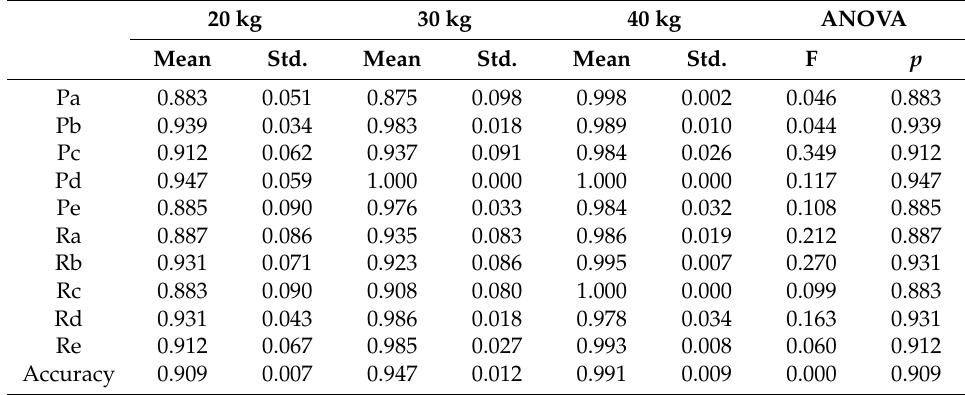
Table 5. Result of ANOVA between weight groups for each performance